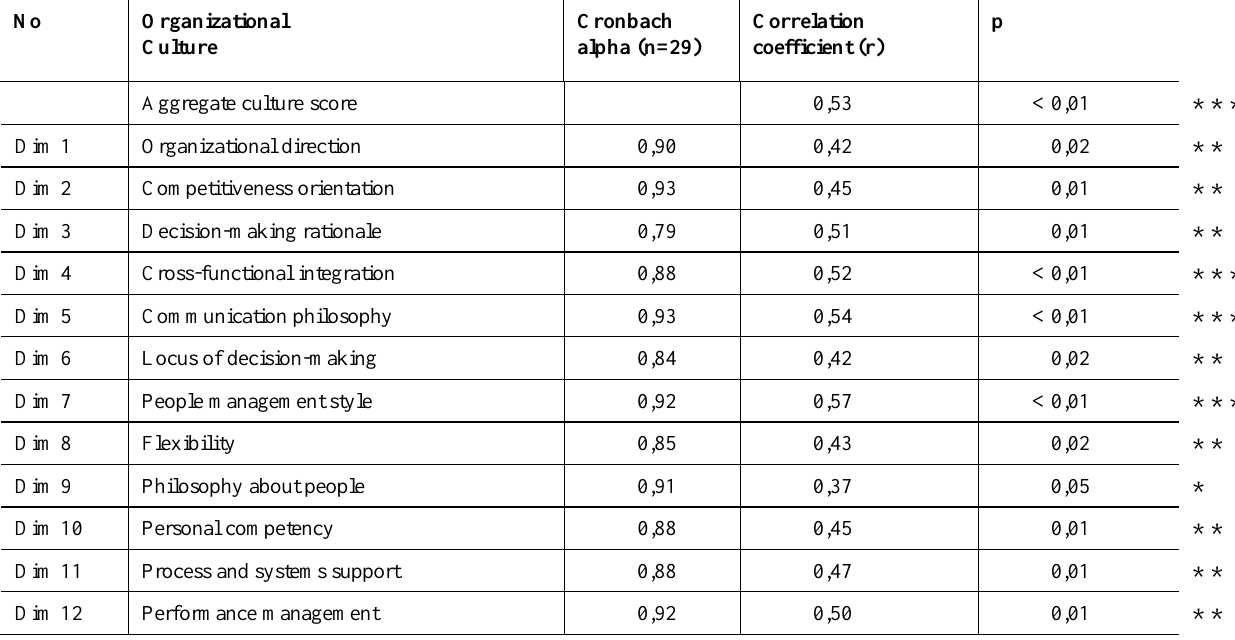
Table 5: Results showing the relationship between organizational culture and project management effectiveness No